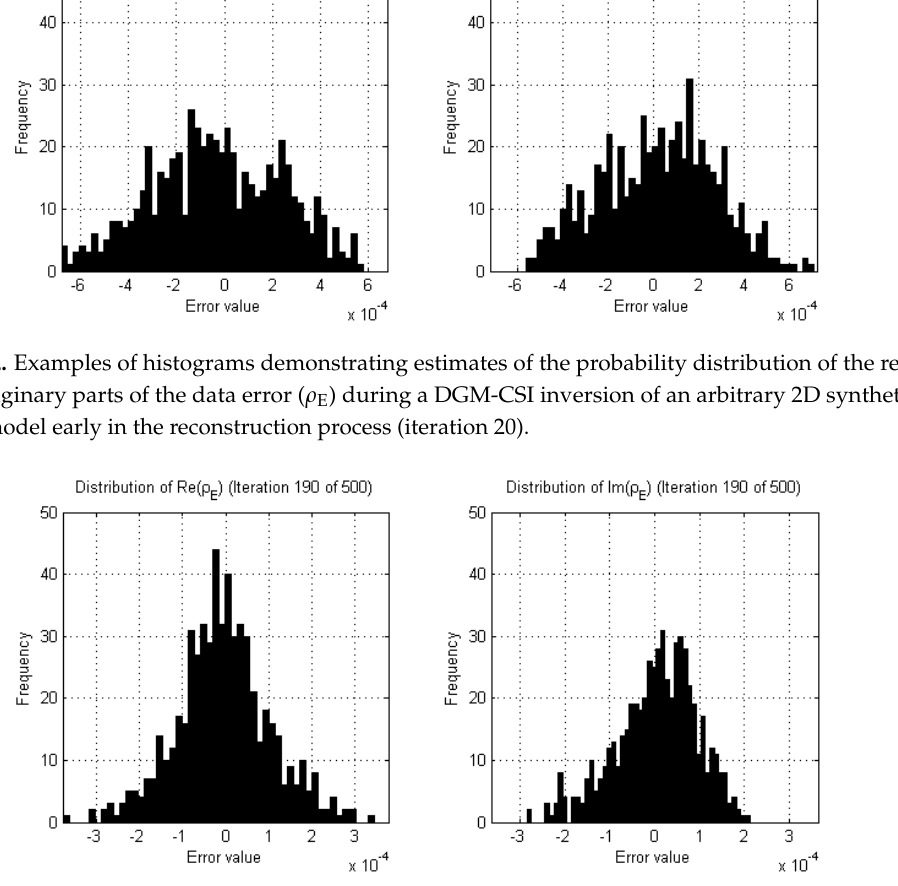
Figure 3. Examples of histograms demonstrating estimates of the probability distribution of the real and imaginary parts of the data error ( ρ E ) during the same DGM-CSI inversion as Figure 2, later in the reconstruction process (iteration